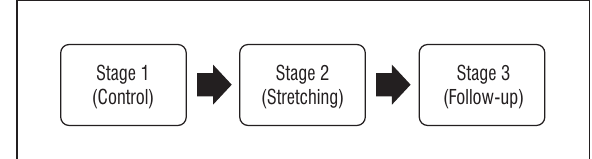
Figure 1 - Schematic representation of the study stages Source: Research